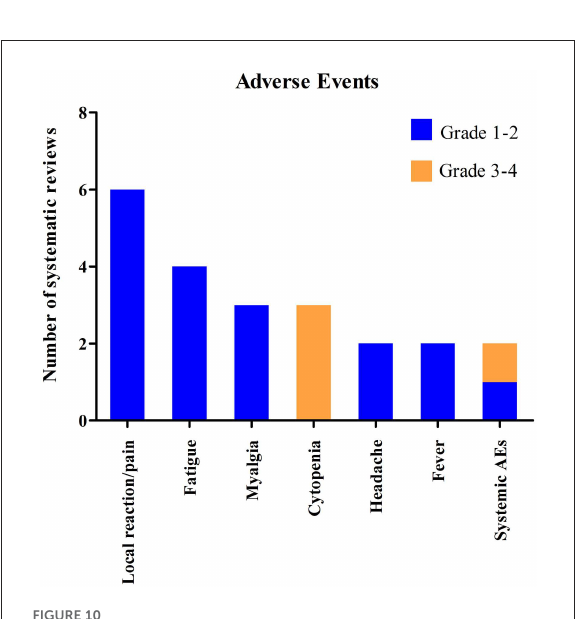
FIGURE10 Systematic reviews included in the systematic review which investigated the adverse events of COVID-19 vaccines in cancer patients.